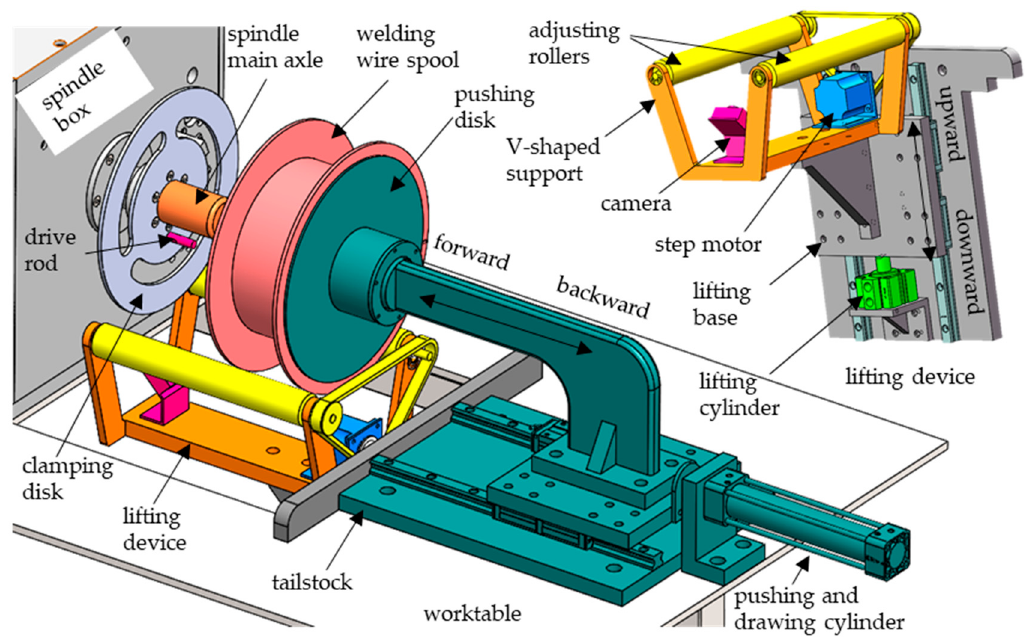
Figure 3. The designed mechanical system for automatic spool loading and clamping.